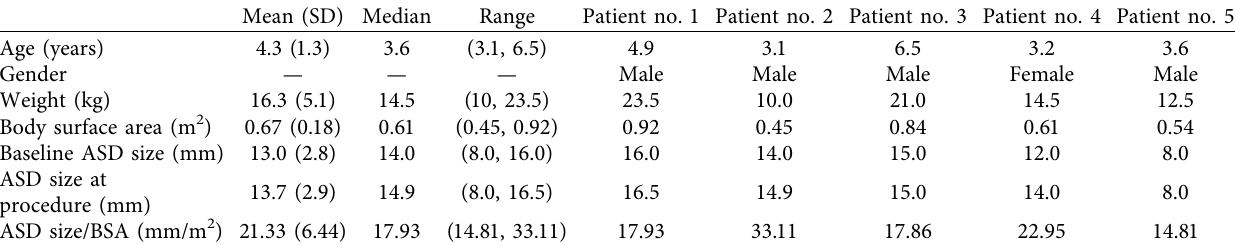
Table 1: Patient demographics.